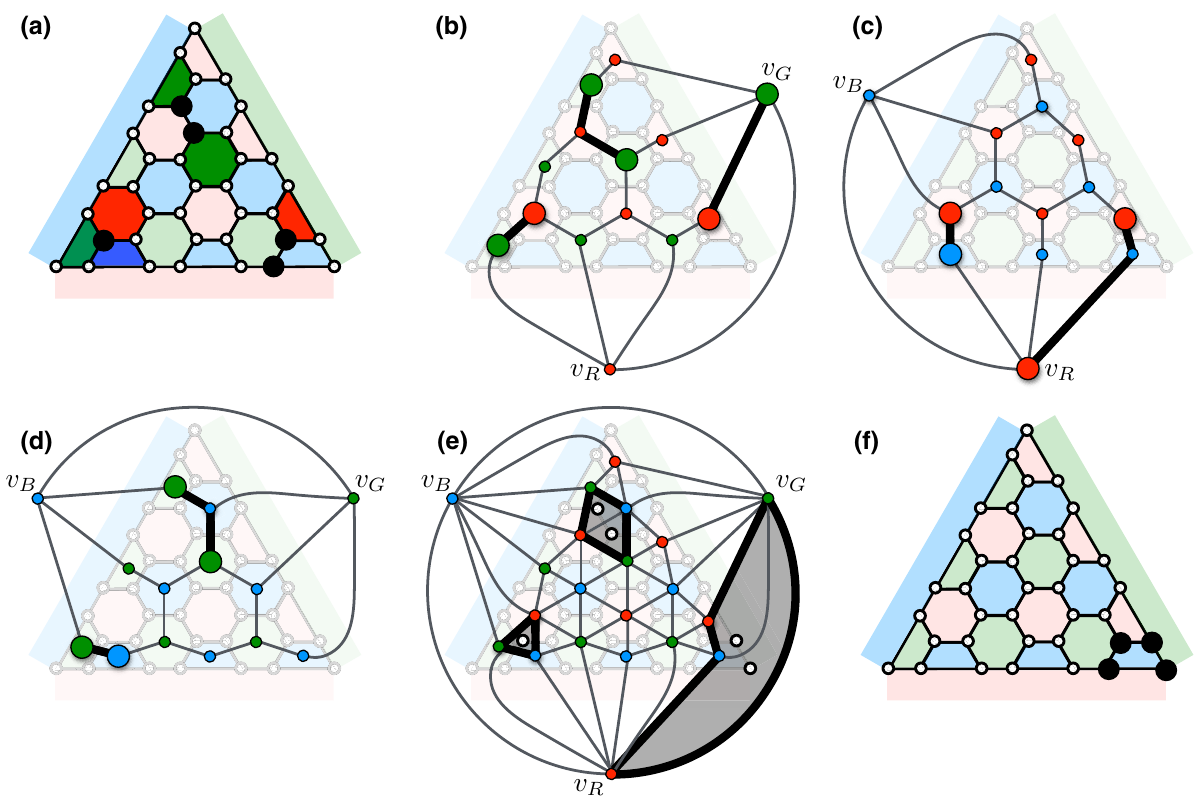
FIG. 9. The projection decoder for the 2D color code of distance d = 7 on the lattice L 2D . (a) The primal lattice with errors (black dots) and the corresponding syndrome (highlighted faces). (b)–(d) We find pairings E RG , E RB , and E GB (thick lines) of highlighted vertices V RG , V RB , and V GB within the restricted lattices L RG , L RB , and L GB , respectively. Note that in (b),(c) boundary vertices v G and v R are included as highlighted vertices. (e) The error estimate is the region (shaded) with boundary E the minimal number of qubits (white dots). (f) The decoding succeeds since the initial error and the estimate differ by a stabilizer (black dots in the primal